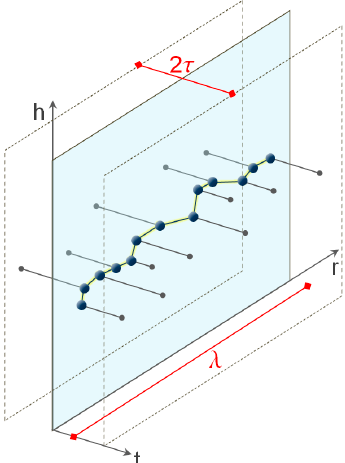
Figure 5. Projection of the points of a strip of point cloud on a vertical plane for a strip of λ long and 2 τ thick.